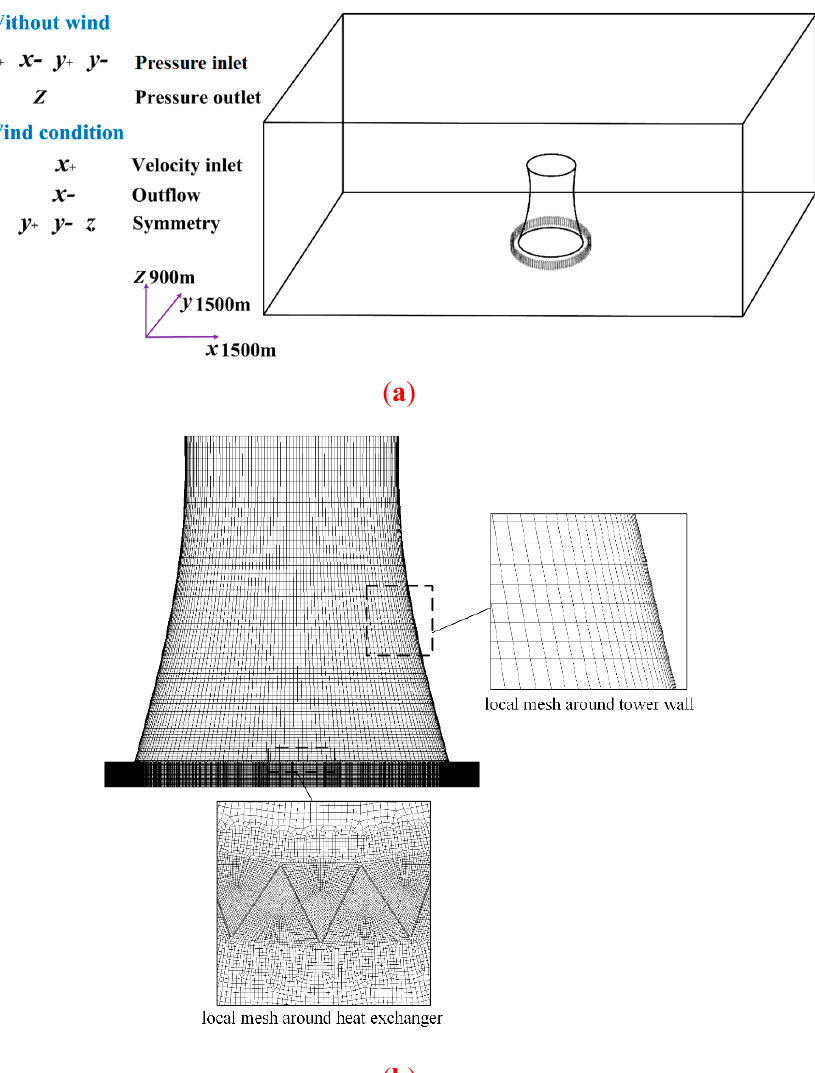
Figure 4. Computational domain and detailed local meshes. ( a ) Computational domain and boundary condition, ( b ) local meshes.